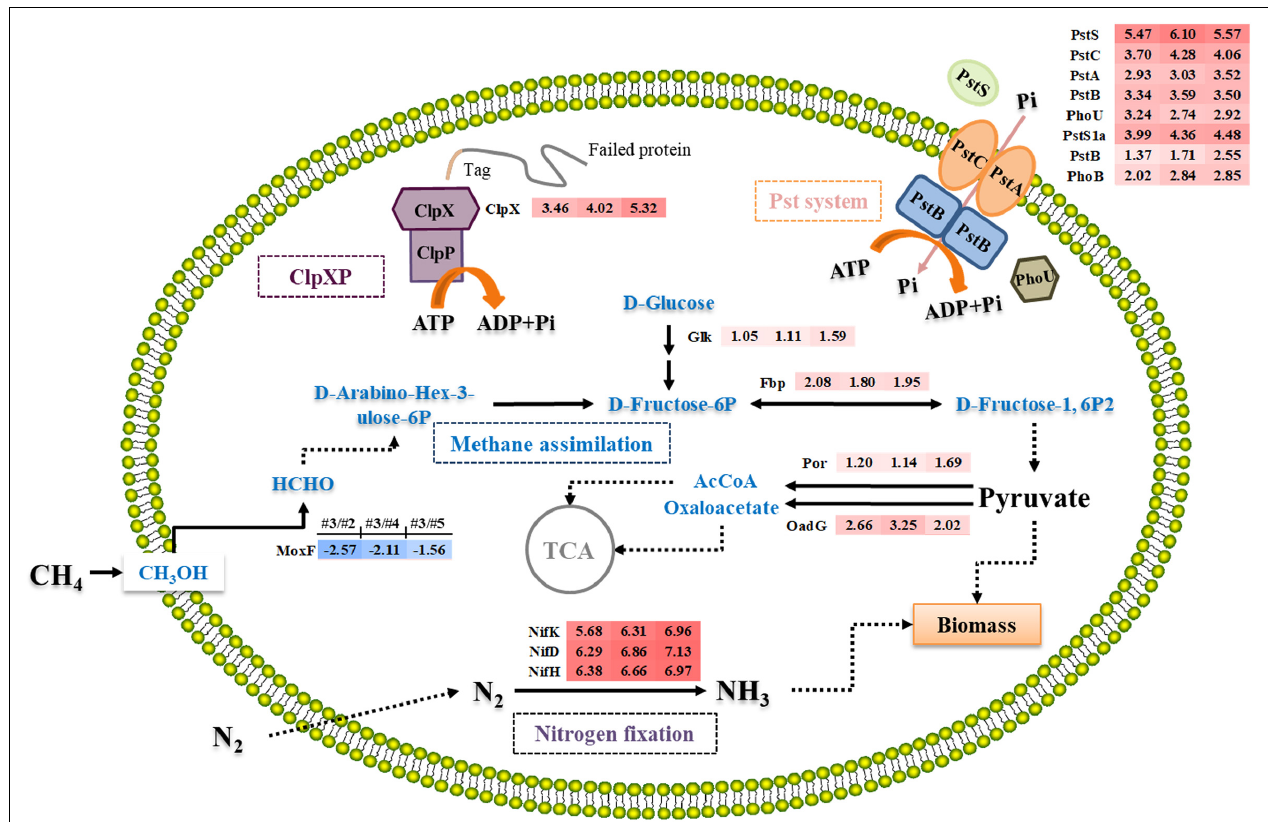
FIGURE 4 | Overview of the differential expression of genes encoding enzymes involving in nitrogen fixation, methane metabolism, ClpX system, and Pst system in M. buryatense 5GB1 in condition #3 (0.93) compared with #2 (0.58), #4 (1.31), and #5 (5.24). Dotted arrow indicates multi-step reaction, while solid arrow represents one-step reaction. The numbers in shadow at right-side of protein represent the log 2 -based changes of differentially expressed gene under condition #3 compared to #2, #4, or #5, respectively. The red shadow means upregulation, while the blue shadow means downregulation.